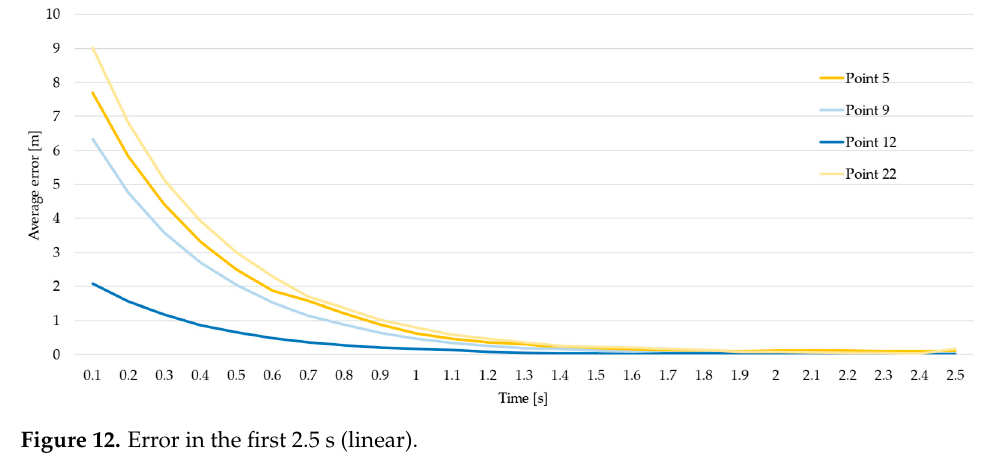
Figure 12. Error in the first 2.5 s (linear).